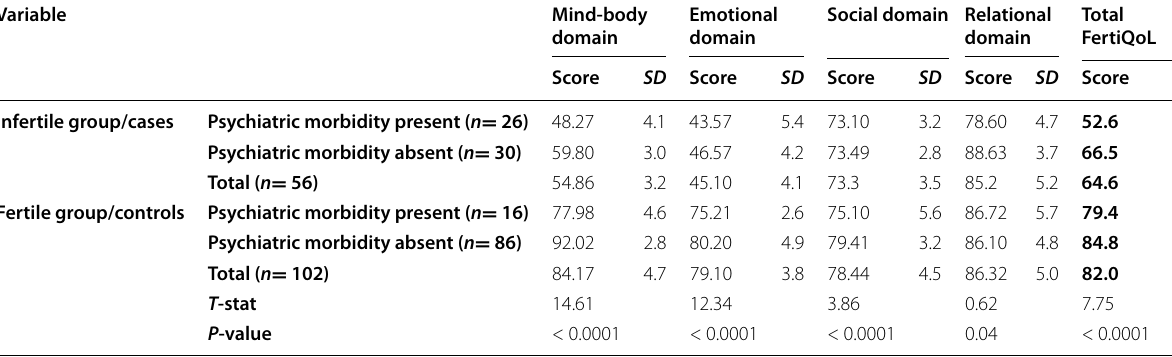
Table 2 Relationship between FertiQoL scale and infertility Variable Mind-body